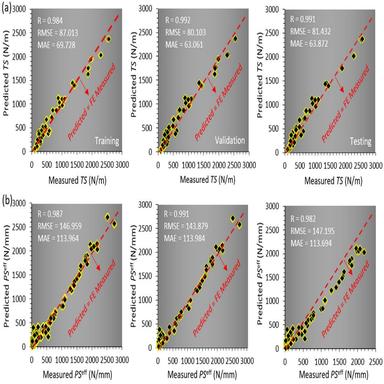
Comparisons of the numerically measured and predicted (a) tensile stiffness and (b) effective postbuckling compressive stiffness in the categories of training, validation and testing.